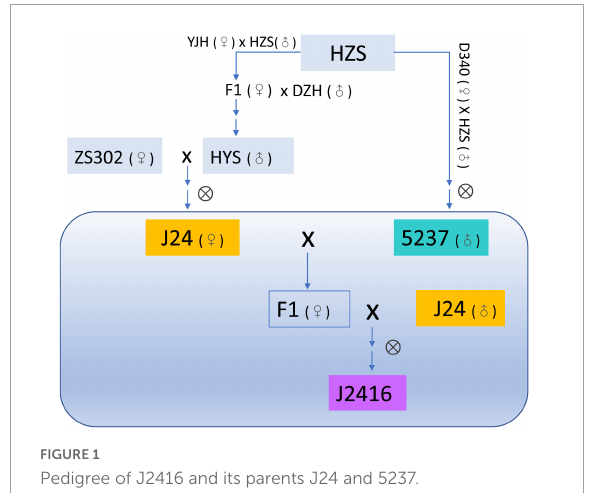
FIGURE1 Pedigree of J2416 and its parents J24 and 5237.